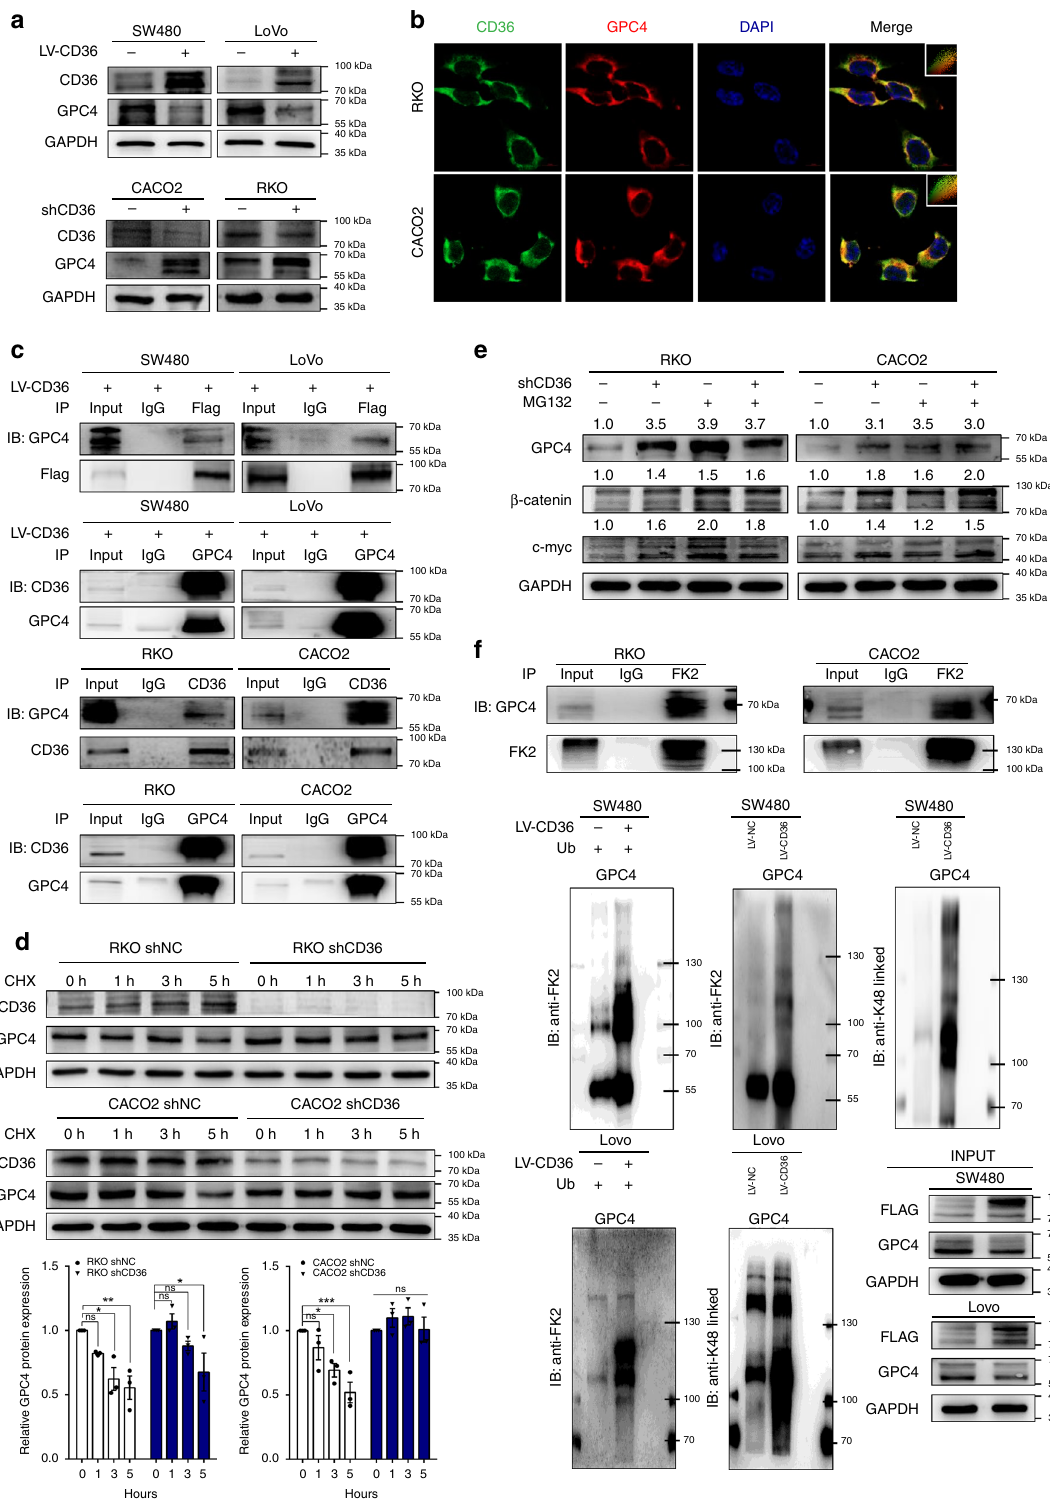
Fig. 4 CD36 mediates proteasome-dependent ubiquitination of GPC4. a Protein levels of GPC4 in CRC cell lines with different CD36 expressions. b IF analysis of the co-localization of CD36 (green) and GPC4 (red) in RKO and CACO2 cell lines. c Co-immunoprecipitation (Co-IP) identi fi ed the interaction between CD36 and GPC4. d Time indicated cycloheximide (CHX, 20 μ g/ml) treatment to compare the stability of GPC4 in indicated cell lines. Results are shown as mean ± SEM ( n = 3), * P < .05, ** P < .01, *** P < .001, based on two-way ANOVA. e MG132 (20 μ M, 24 h) treatment on RKO and CACO2 cells with/without CD36 knockdown. f Co-IP determined endogenous ubiquitination and proteasome-dependent ubiquitination of GPC4. Source data are provided as a Source Data fi